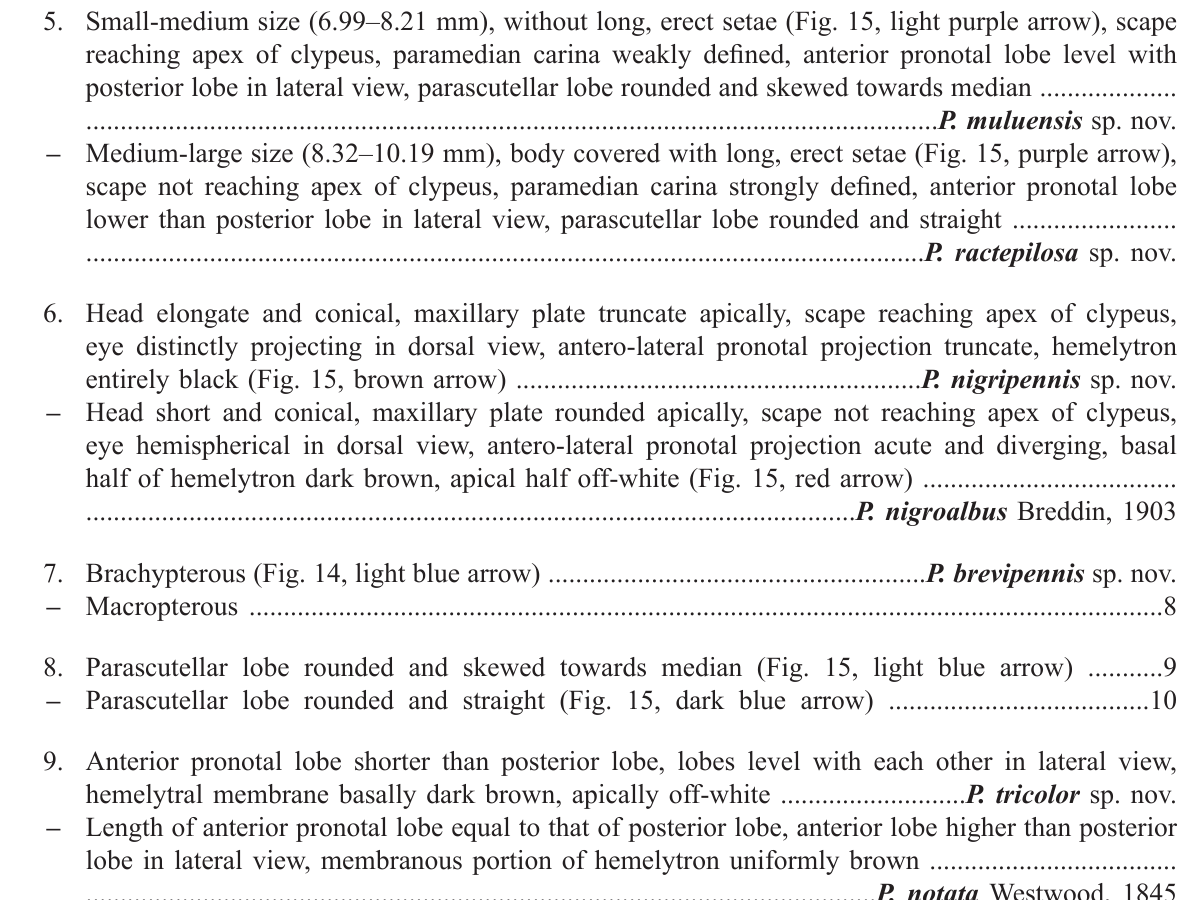
Fore femur slender, slightly incrassate, hemelytron not reaching tip of abdomen (Fig. 15, orange arrows) ................................................................................................................................................5 Fore femur distinctly incrassate, hemelytron reaching tip of abdomen (Fig. 15, brown arrow) ....6 reaching apex of clypeus, paramedian carina weakly defined, anterior pronotal lobe level with posterior lobe in lateral view, parascutellar lobe rounded and skewed towards median ....................